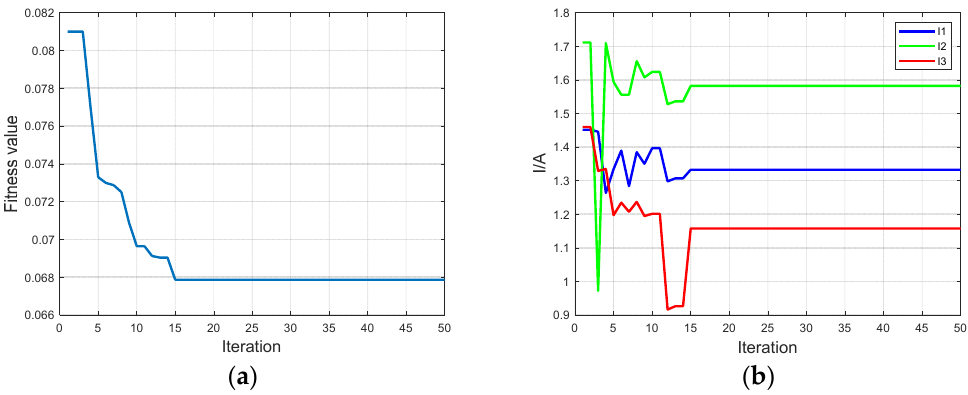
Figure 7. Three-stage constant current charging strategy optimization curve: ( a ) fitness value curve; ( b ) phase current value curve. Table 2. Simulation results of four-stage constant current charging strategy.